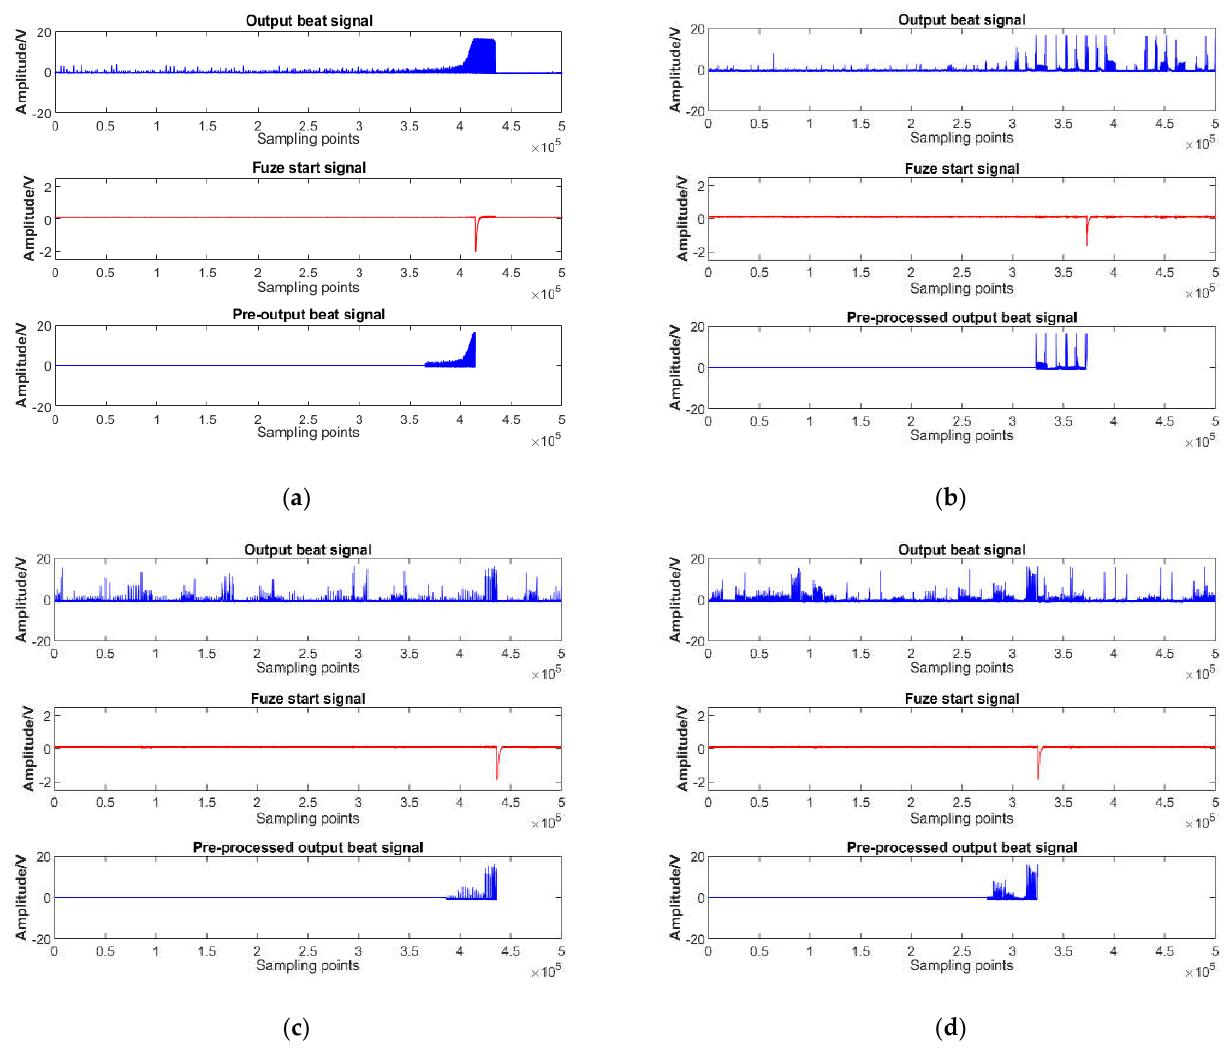
Figure 2. FMCW fuze beat output signals and start signals under target and jamming signals action. ( a ) Output signals under target action; ( b ) output signals under noise amplitude frequency swee-ing jamming signals; ( c ) output signals under sine amplitude frequency sweeping jamming signals; ( d ) output signals under square amplitude frequency sweeping jamming signals.